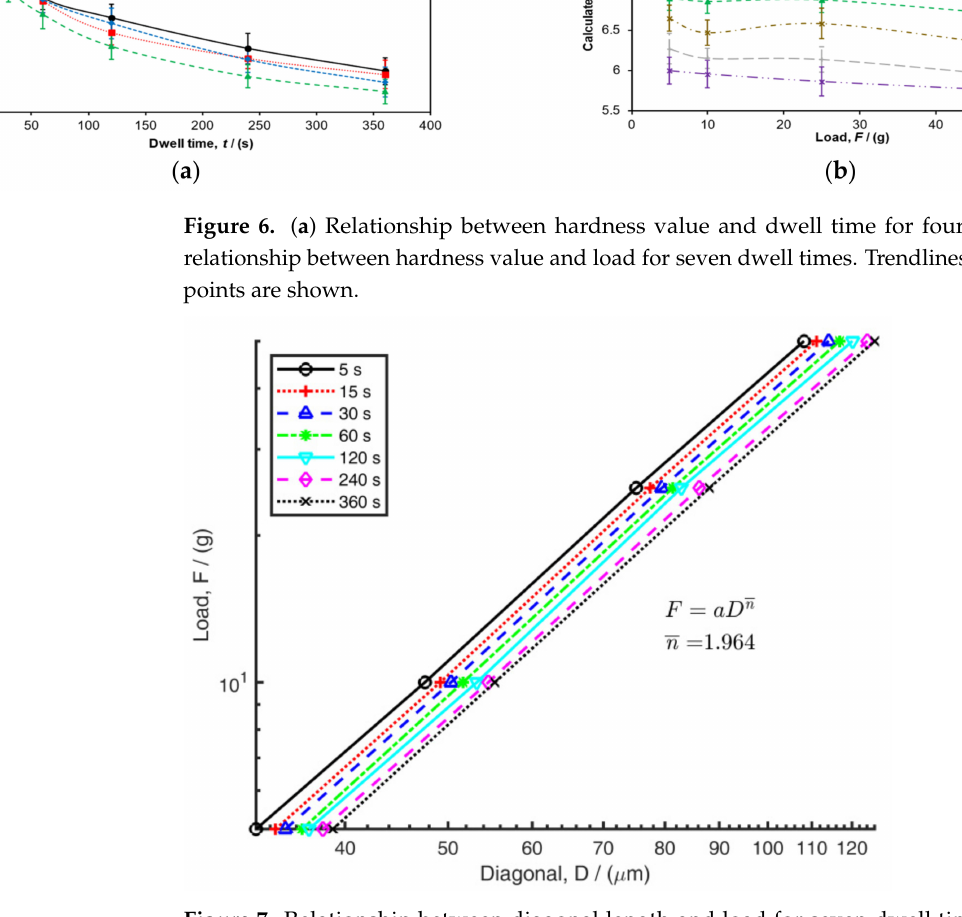
Figure 7. Relationship between diagonal length and load for seven dwell times. Lines of best fit are